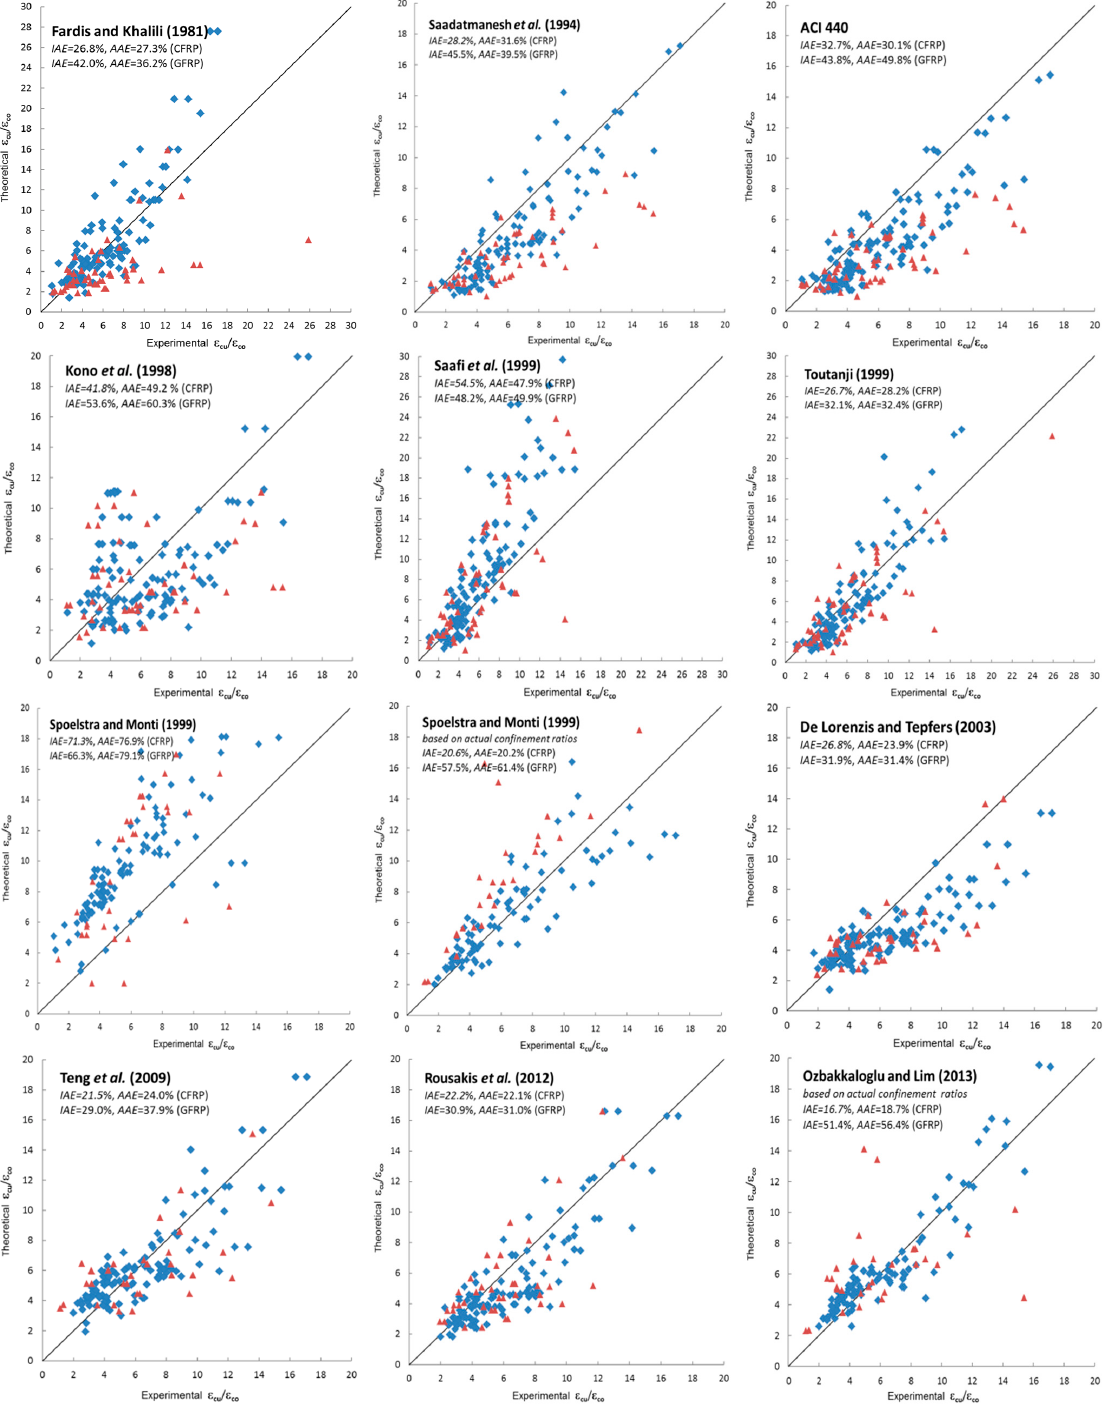
Figure 3. Accuracy of strain models in the current literature columns confined with CFRP and GFRP wraps ( f co from 15 to 110 MPa, ♦ for CFRP sheets, ▲ for GFRP sheets). The strain models of this study were expressed and verified in detail (Table 3). These models were categorized in two groups (CFRP, GFRP) in terms of confinement ratios ( f l / f co , f l,a / f co ), as per